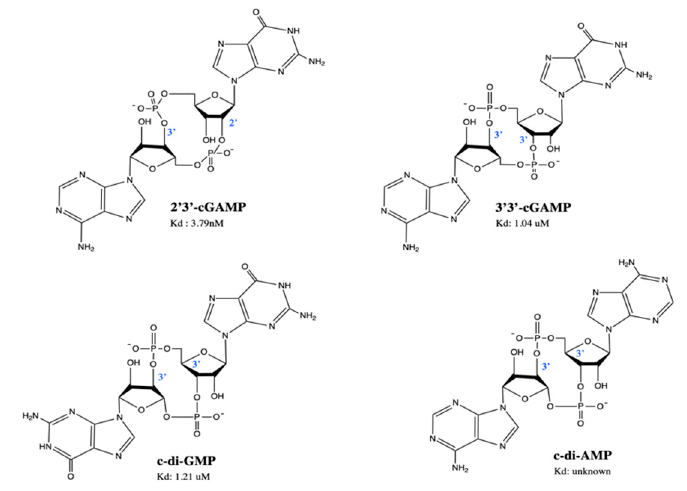
Figure 3. Structures of naturally occurring cyclic dinucleotides. 2 ′ 3 ′ -cGAMP is the native ligand of STING, found in eukaryotic cells. 3 ′ 3 ′ -cGAMP, c-di-GMP and c-di-AMP are found in prokaryotic cells. Kd (dissociation constant) represents the affinity of STING binding to the cyclic dinucleotides. This is an original figure created with ChemDraw.